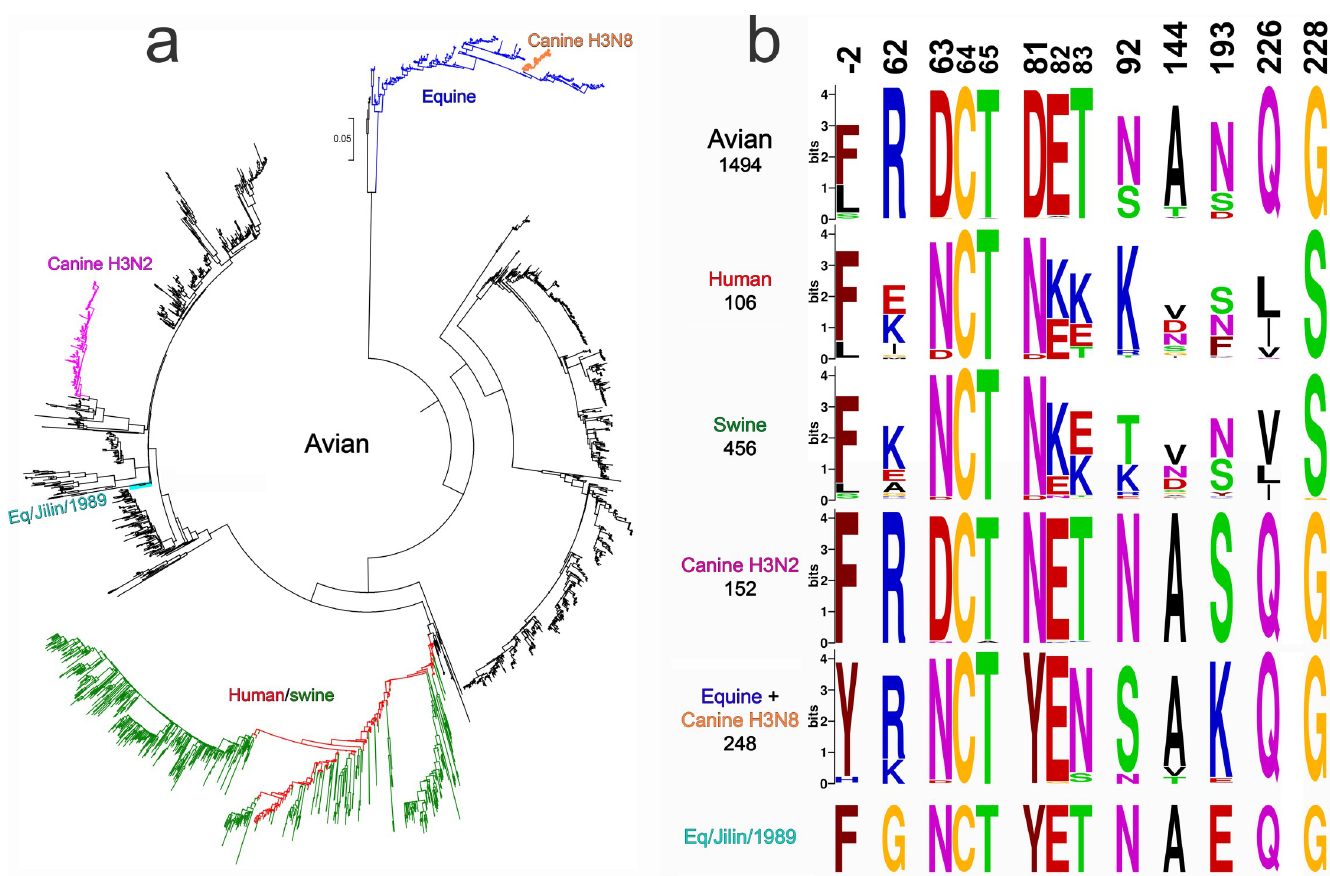
Fig 10. Host-specific lineages of IAVs with H3 HA and variation of amino acids at selected HA positions. ( a ) Phylogenetic tree for the H3 HA nucleotide sequences of representative sequences of human and swine viruses and all unique sequences of other mammalian and avian viruses available from GISAID EpiFlu database. The numbers of analysed sequences are shown in panel 10b below the lineage name. S5 Fig shows the same tree with strain names, accession numbers and amino acids at 9 HA positions under study. ( b) Protein logos for indicated HA positions of the viral lineages shown in panel 10a. The overall height of each stack of letters depicts sequence conservation measured in bits. The height of each letter is proportional to the frequency of the corresponding amino acid in the alignment, the letters are ordered from most to least frequent. Only one sequence was available for the Eq/Jilin/1989 lineage.